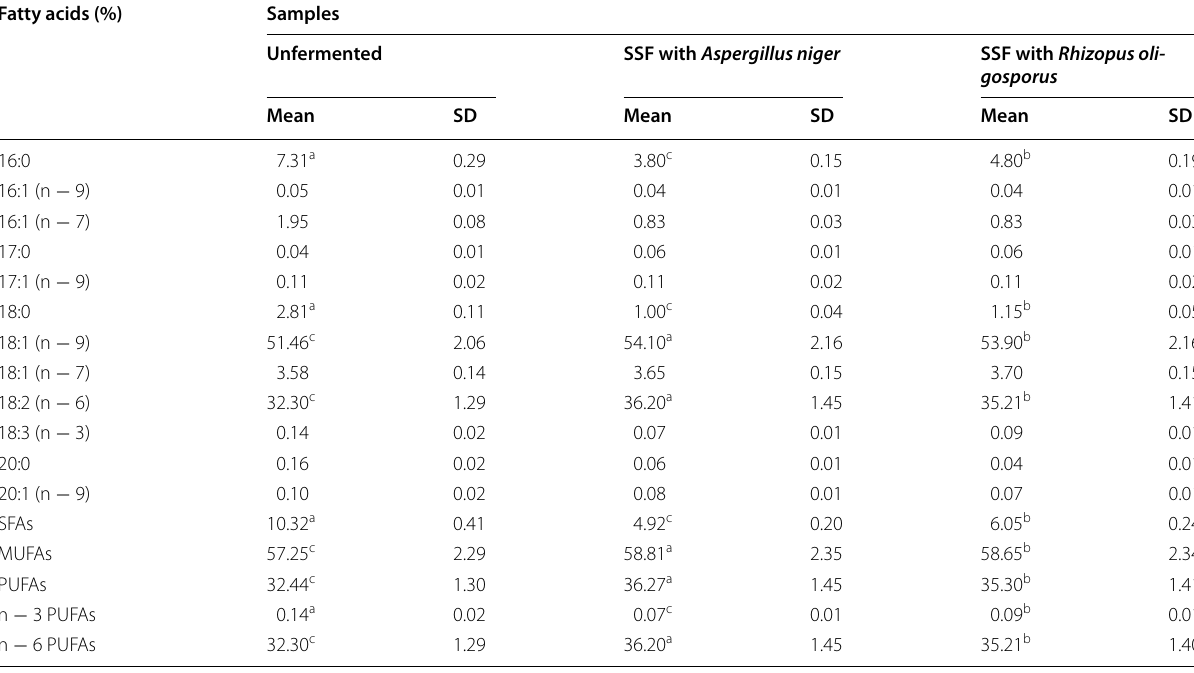
Table 2 Fatty acid compositions (%) (determined by GC–MS) of total lipids produced by Aspergillus niger and Rhizopus oligosporus in solid-state fermentation (day 2) of apricot kernels